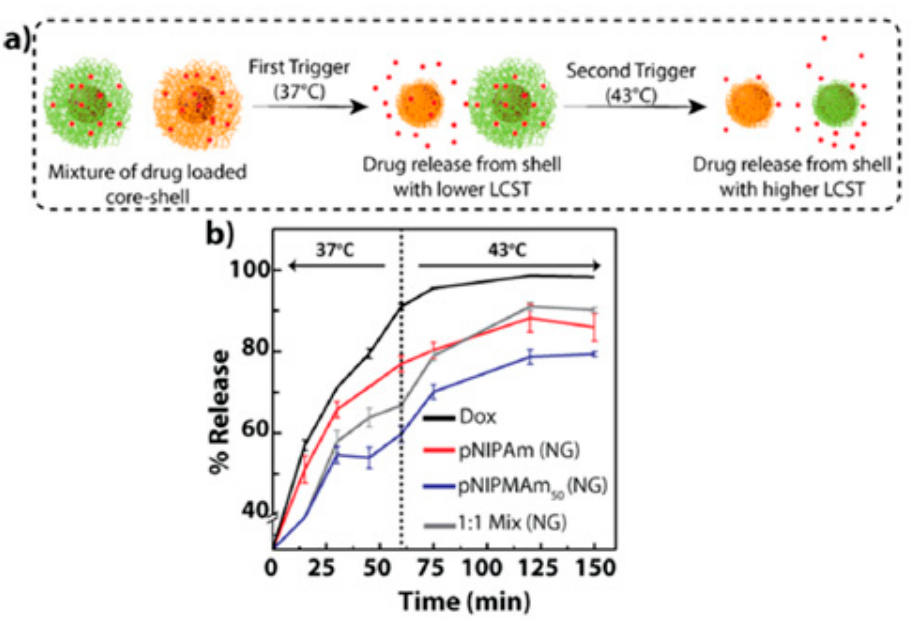
Figure 5. NIPAM and NIPMAM-based thermosensitive core–shell nanogels for triggered and sustained release of DOX. ( a ) Schematic diagram showing the trigger-based release and ( b ) sustained release of DOX from the nanogels. Adopted from Ref. [84] reproduced by permission of American Chemical Society. Further permissions related to the material excerpted should be directed to the ACS.